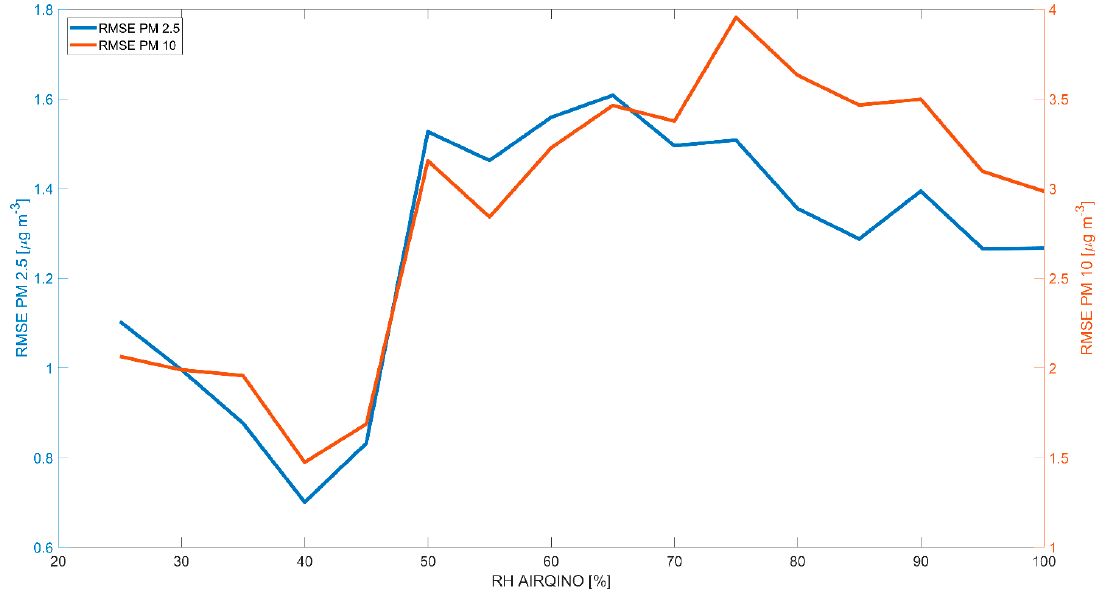
Figure 6. Root mean square errors (RMSE) between the AIRQino PM 2.5 (blue line, left y-axis), AIRQino PM 10 (orange line, right y -axis), and GAL. Hourly PM data were binned on the basis of 5%-wide RH bins ( x -axis) and RMSE was computed over such bins. Table 1 summarizes the results for the whole year of comparison of daily averages of AIRQino and reference sensors for the various variables. Table 1. Metrics and statistics between the AIRQino and the reference sensors. For GAL-GRAV the statistics are referred to the comparison AIRQino.